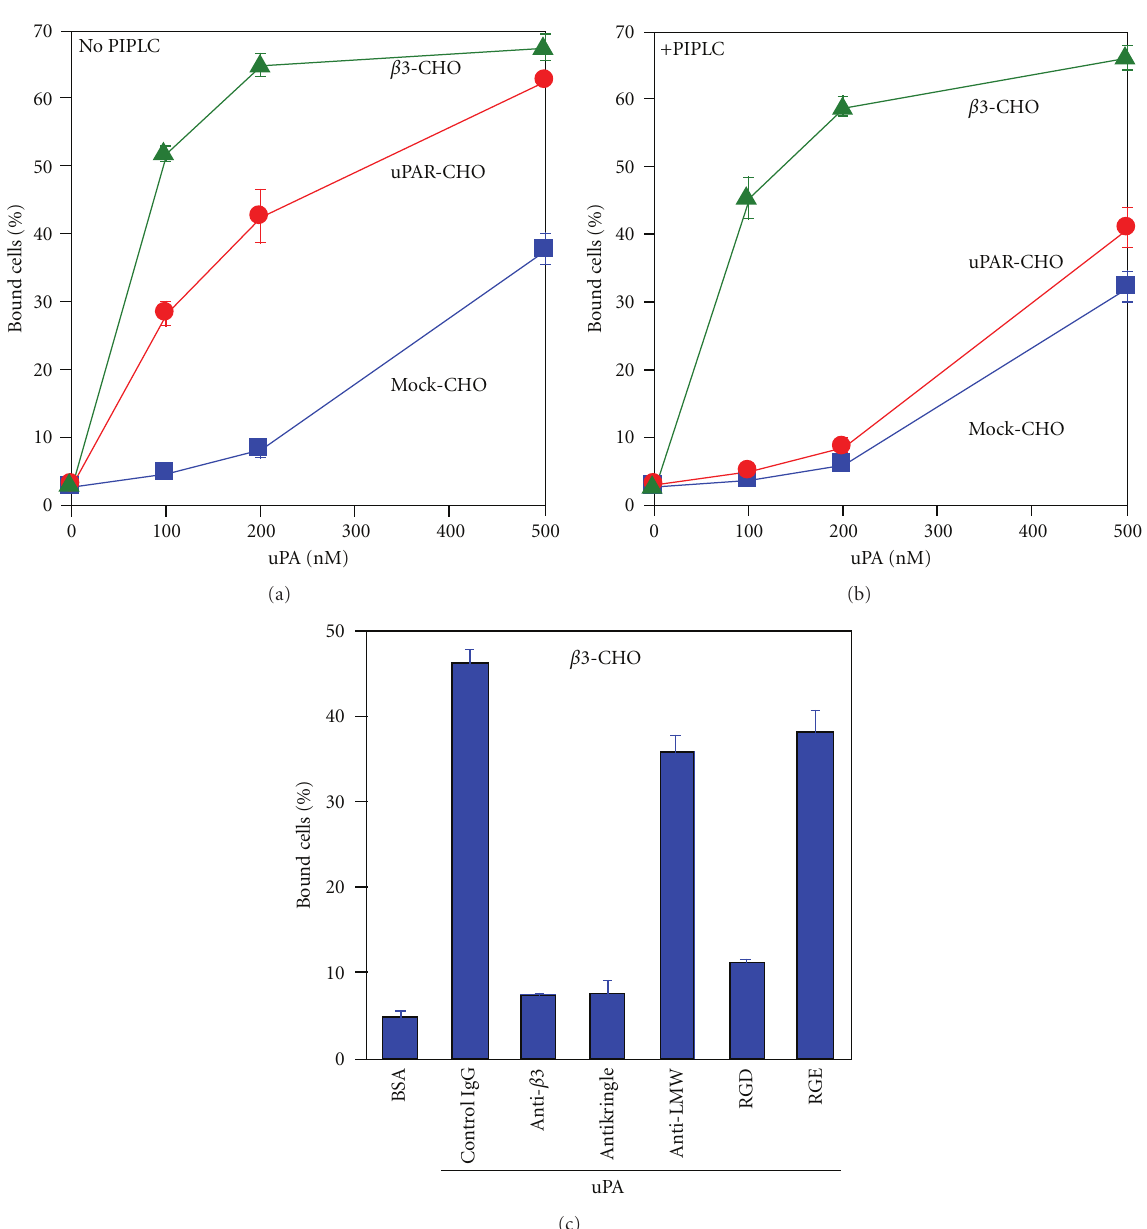
Figure 2: uPA binding to the cell surface in an integrin α v β 3-dependent and uPAR-independent manner [38]. (a) and (b) Depletion of uPAR from the cell surface blocked uPA binding to uPAR-CHO cells, but did not a ff ect uPA binding to β 3-CHO cells. To deplete GPI-linked uPAR on the cell surface, β 3-CHO, uPAR-CHO, or control mock-transfected CHO cells were treated with PIPLC. The treatment removed more than 95% of human uPAR from uPAR-CHO cells as determined by flow cytometry with anti-uPAR mAb 3B10 (data not shown). uPA was immobilized to wells of 96-well microtiter plates at the indicated coating concentrations, and incubated with cells without (a) or with (b) pretreatment with PI-PLC. Bound cells were quantified. (c) uPA binding to β 3-CHO cells is specific to α v β 3 and the kringle domain. uPA (200nM coating concentration) was immobilized to wells of 96-well microtiter plates and incubated with β 3-CHO cells in the presence of mAb 16N7C2 (anti- β 3), Ab 963 (anti-kringle), mAb UNG-5 (anti-LMW-uPA), or RGD or RGE peptides (100 μ